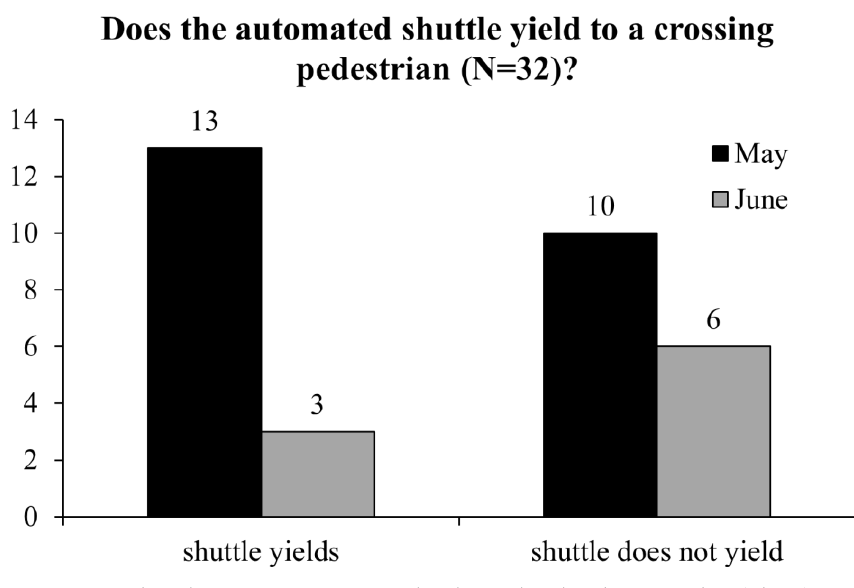
Figure 3 Interactions between autonomous shuttles and pedestrians crossing (Site